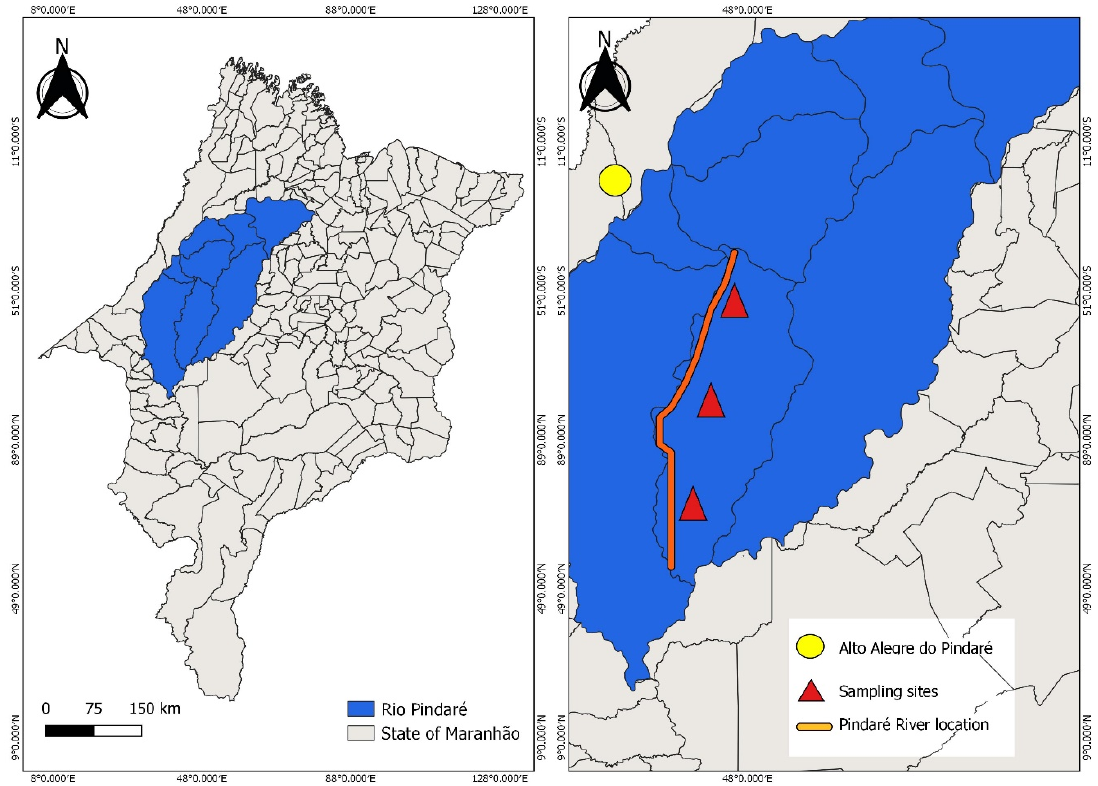
Figure 1. Study area located in the city of Alto Alegre do Pindaré—Maranhão and collection